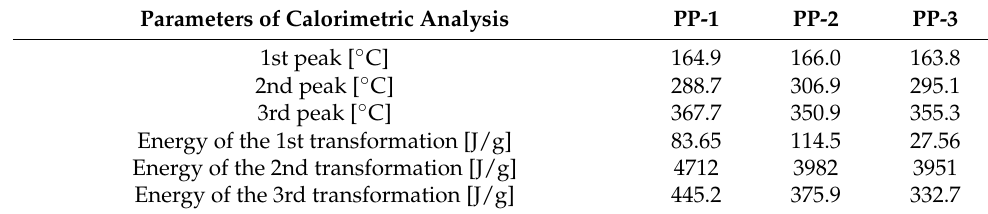
Figure 6. DSC curve for PP ‐ 2. Table 2. Selected parameters for the DSC analysis for